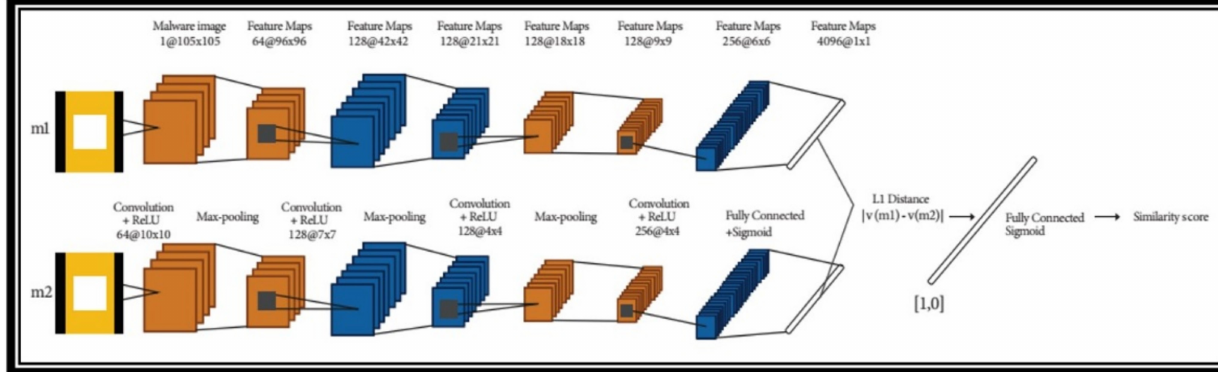
Figure 8. Siamese CNN used by [50].